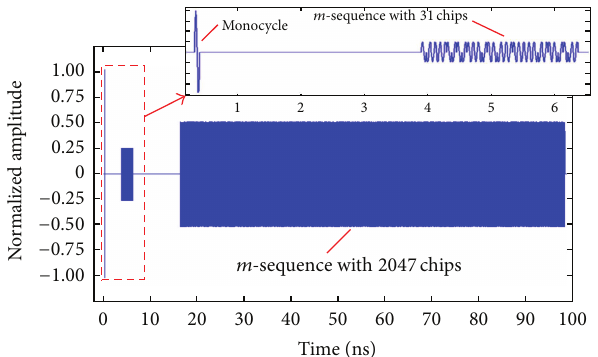
Figure 2: The transmit signal from the signal generator.